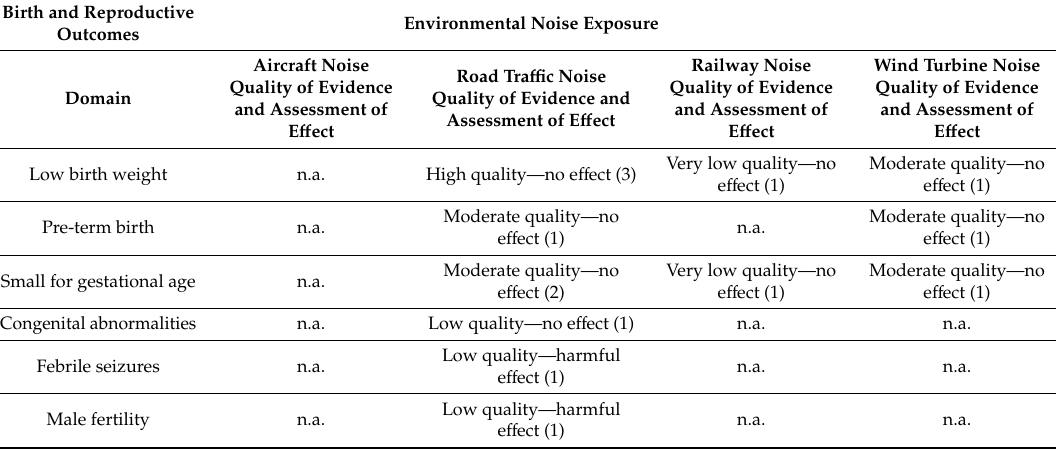
Table 10. Summary of the strength of the evidence for birth and reproductive